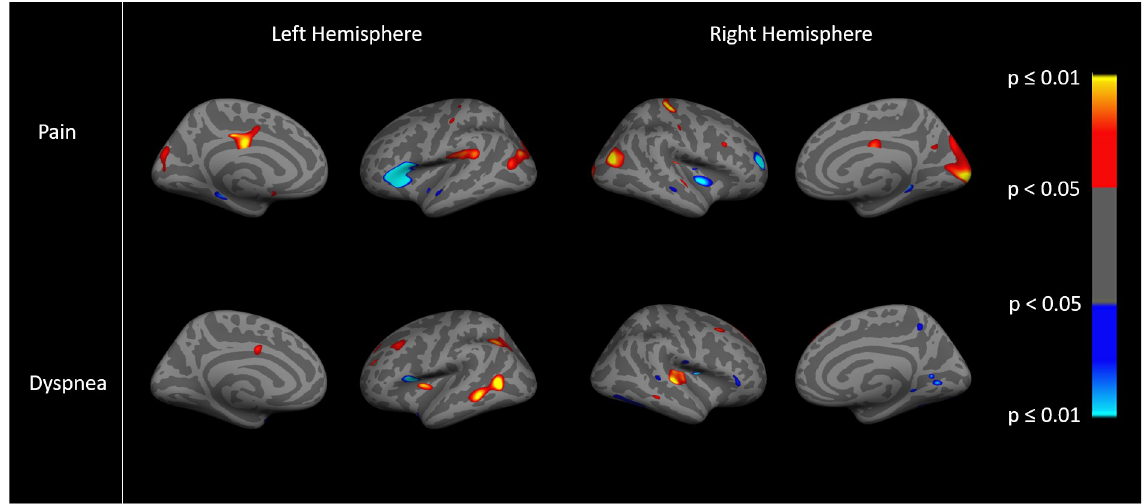
PLOS ONE | https://doi.org/10.1371/journal.pone.0254653 July 15,